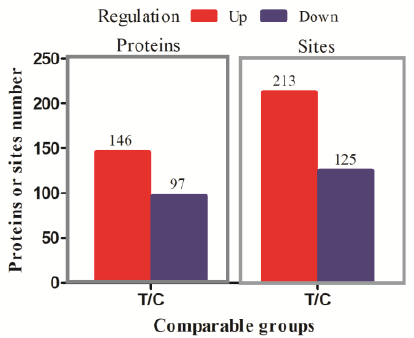
Figure 1. The results of differentially phosphorylated modification sites and differentially phosphorylated proteins (DPPs). A total of 213 sites in 146 DPPs were up-regulated and 125 sites in 97 DPPs were down-regulated (fold change > 1.50 and P adj < 0.05).